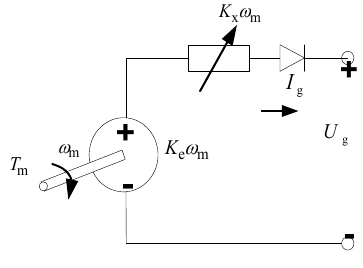
Figure 3. The simplified generator-rectifier equivalent